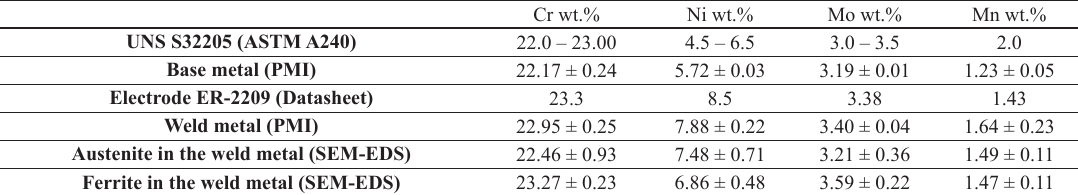
Table 1. Nominal composition of DSS UNS S32205 (ASTM A240) and the consumable electrode (datasheet) compared to the average values determined by PMI technique and elemental distribution between phases in the weld zone (SEM-EDS). Cr wt.%